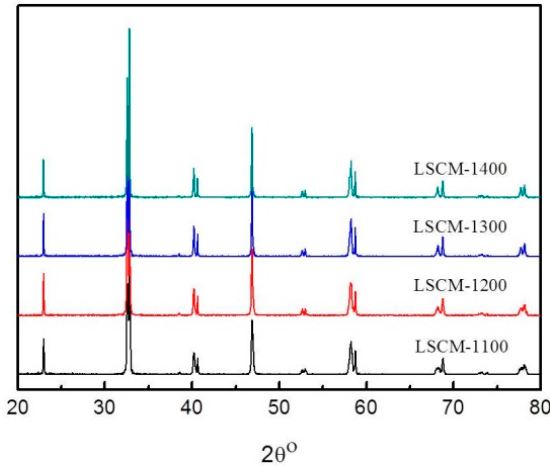
Figure 2. X-ray diffraction (XRD) patterns of the La 0.75 Sr 0.25 Cr 0.5 Mn 0.5 O 3 (LSCM) powders calcined at the temperature of 1100–1400 °C.